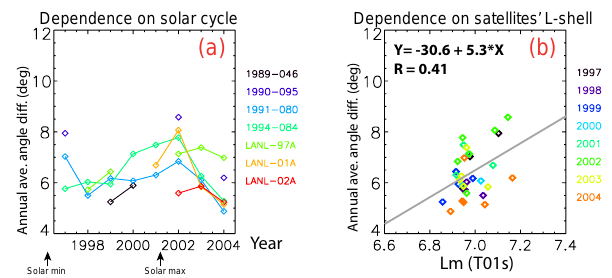
Figure 11. Model performance of T01s depends on solar cycle and satellite positions. (a) Annual average angles are plotted as a func- tion of years for each LANL GEO satellite. (b) Average angles are plotted as a function of L m (McIlwain L shell) for each LANL GEO satellite. Data points are fitted by the gray straight line, whose equa- tion is given on the top of the panel, with a Pearson’s correlation coefficient value of